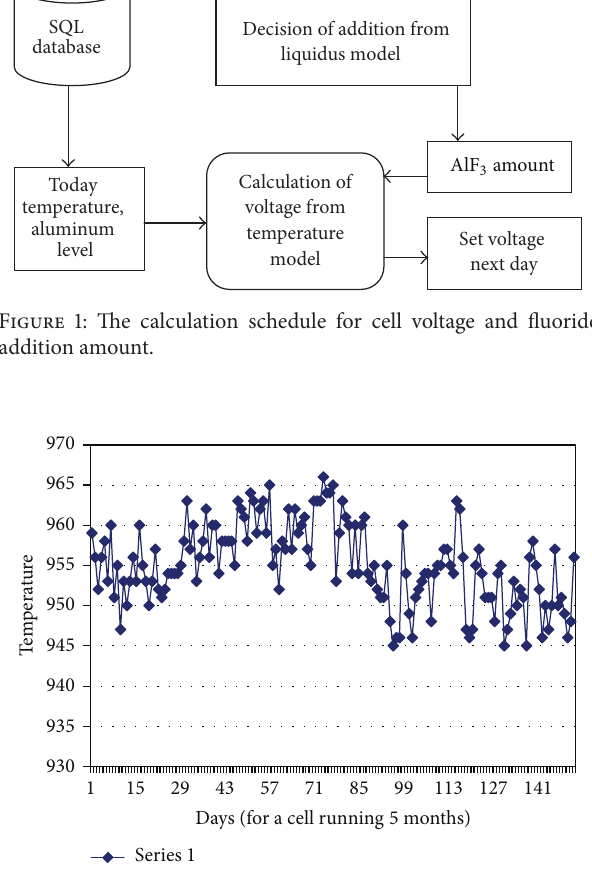
Figure 2: Temperature change (measured once each day).